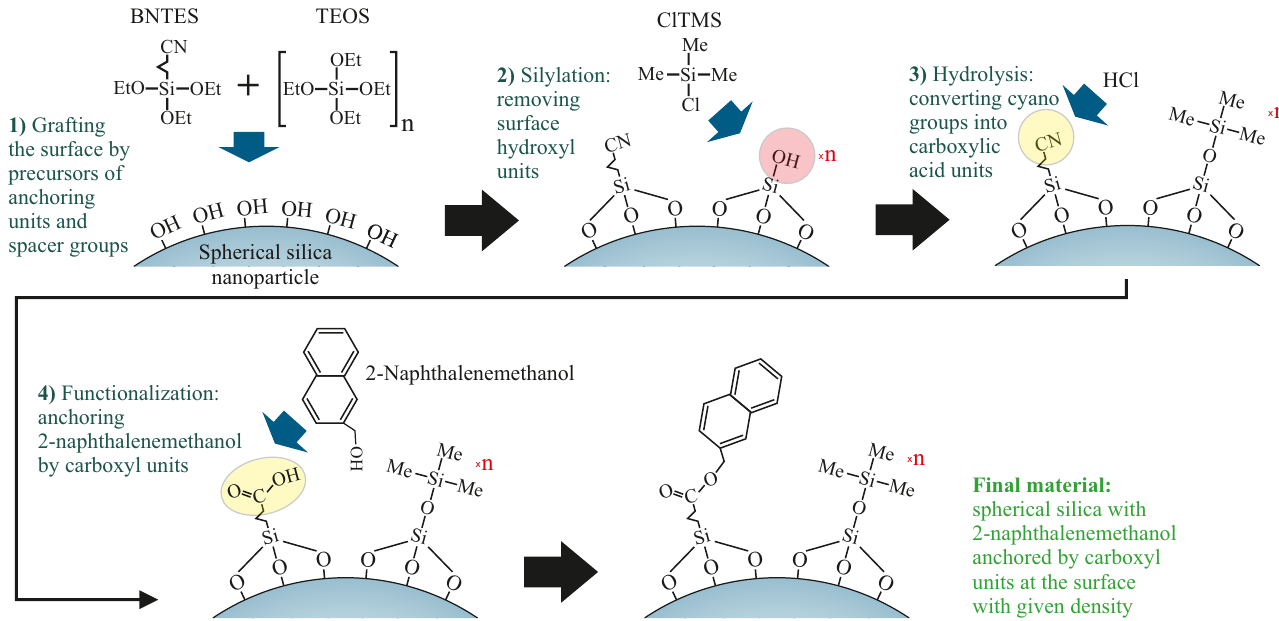
2-naphthalenemethanol anchored by carboxyl units at the surface with given density